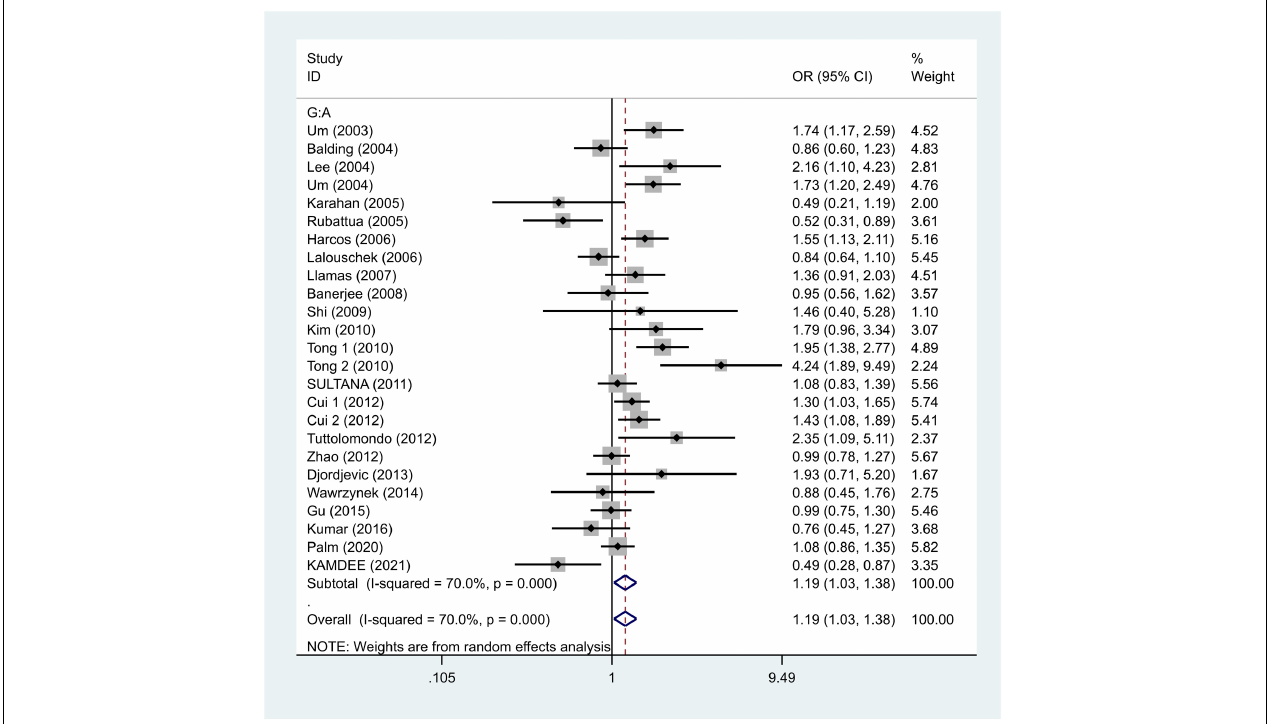
FIGURE 3 | Results of the random-effects meta-analysis for the TNF- α G308A allele (G vs. A) in IS and control groups.